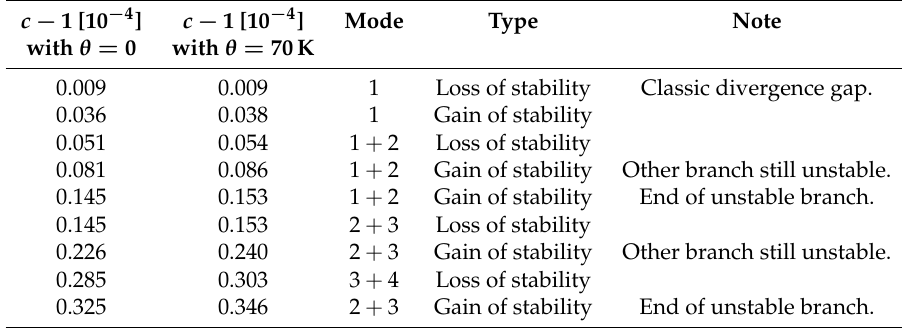
Table 2. Critical points, where the real part of at least one solution enters or exits the positive half-plane. No axial stream, v ∞ = 0.